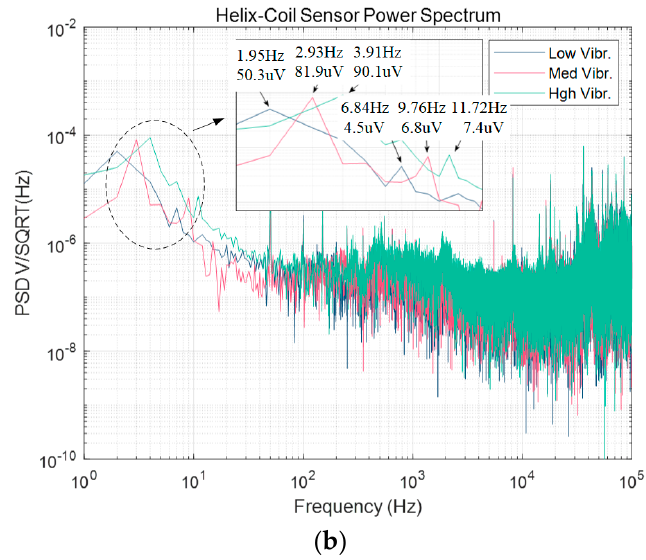
Figure 9. Signals received in the frequency domain under various vibrations. ( a ) The PSD of elec- trode-pair. ( b ) The PSD of helix coil sensors.